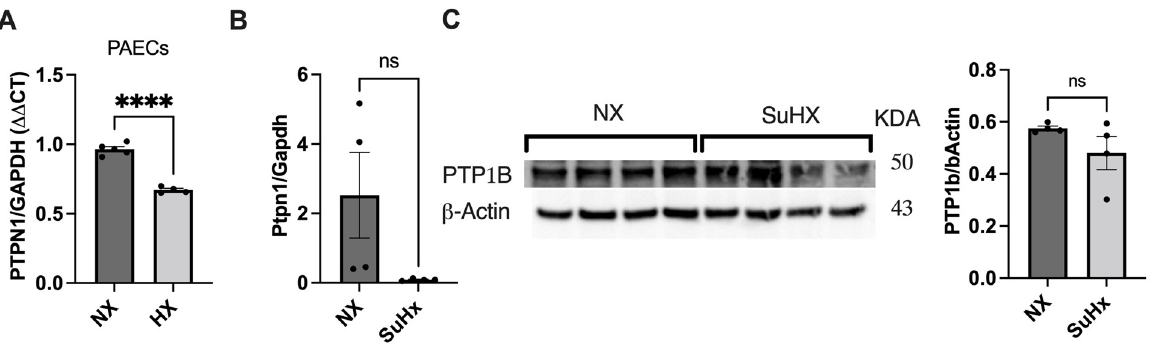
Figure 3. PTPN1 is downregulated in healthy human PAECs exposed to hypoxia and in the lung sugen5416/hypoxia-induced PH rats. ( A ) 150,000 PAECs were seeded onto 6-well plates and exposed to 72 h of hypoxia. After that, PTPN1 expression was measured by qRT-PCR. Induction of hypoxia was verified by measuring VEGF expression by qRT-PCR [20]. ( B , C ) PTPN1 mRNA and protein expression was also measured in the lung of sugen5416/hypoxia rate models by qRT-PCR and western blotting (please see the PH model description and phenotypes data in [8]). Data are represented as mean ± standard error mean, n = 3–5; student t -test was performed to compare data between two samples. **** p < 0.0001. ns, not significant